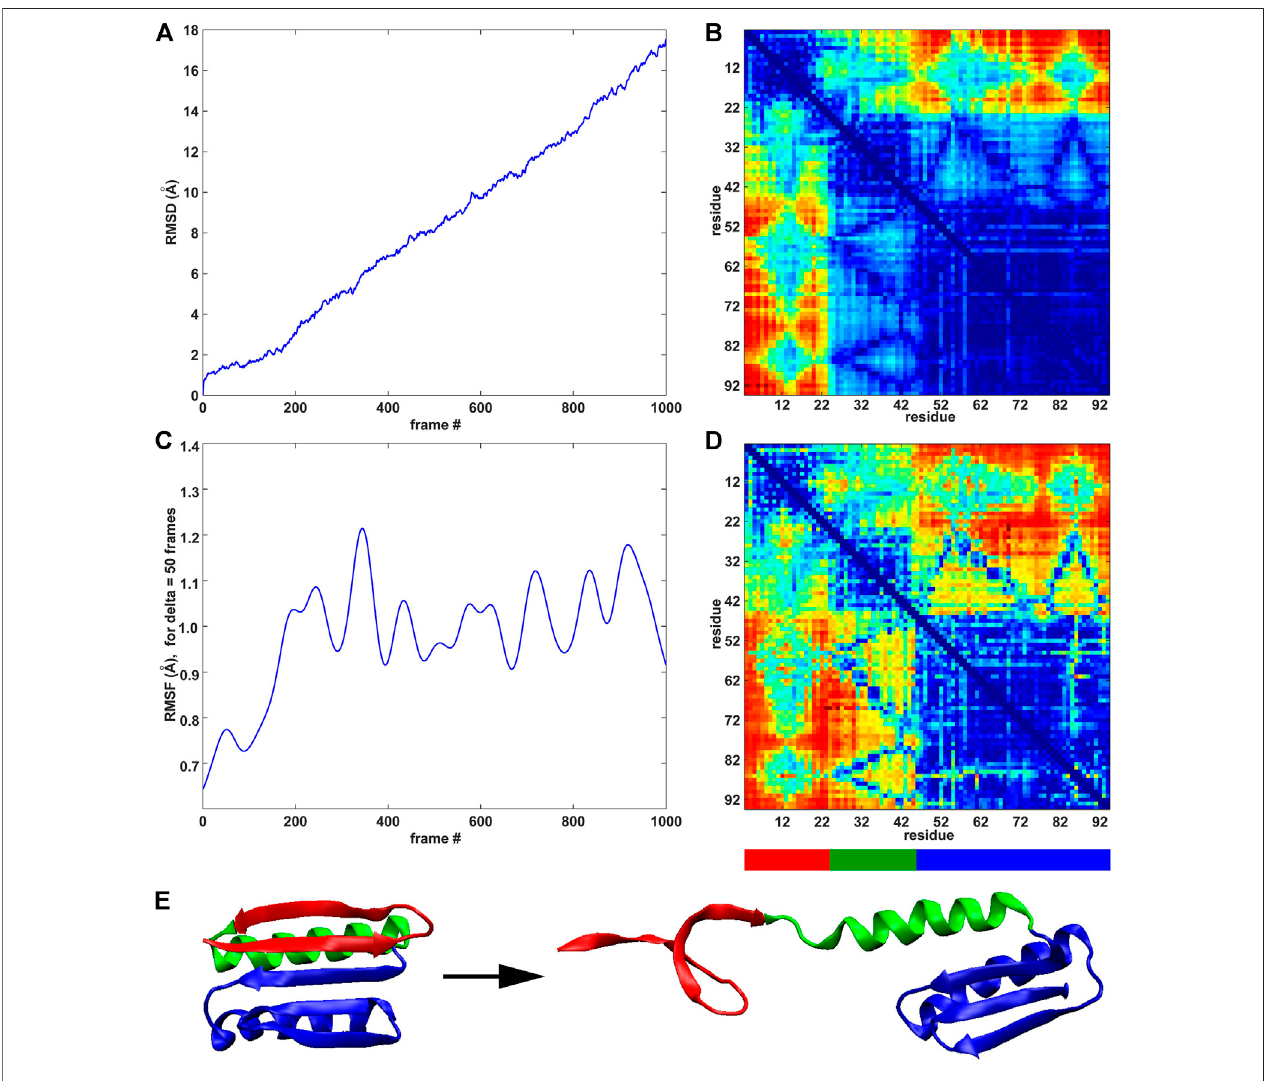
FIGURE 4 | MI analyses of the constant velocity unfolding trajectory against RMSD order parameter and RMSF activity function. (A) RMSD curve (see text). (B) Pairwise residue matrix created by direct MI against RMSD (color scale as in Figure 2 , right). (C) RMSF curve ( Figure 2A ). (D) Pairwise residue matrix created by direct MIagainstRMSF(colorscaleasin Figure2 ,right). (E) CartoonrepresentationoftheproteinwithcoloredsegmentsemphasizedbytheMIanalysisdepictedin (B,D) .The red segment (residues 3 – 22) is the most active (see the highly active band in panel (B) ), showing the activity of residues 3 – 22 against all other residues. The green segment (residues 23 – 44) is less active than the red segment (see panel (B) ), whereas the blue segment (residues 45 – 94) remains stable (see text for